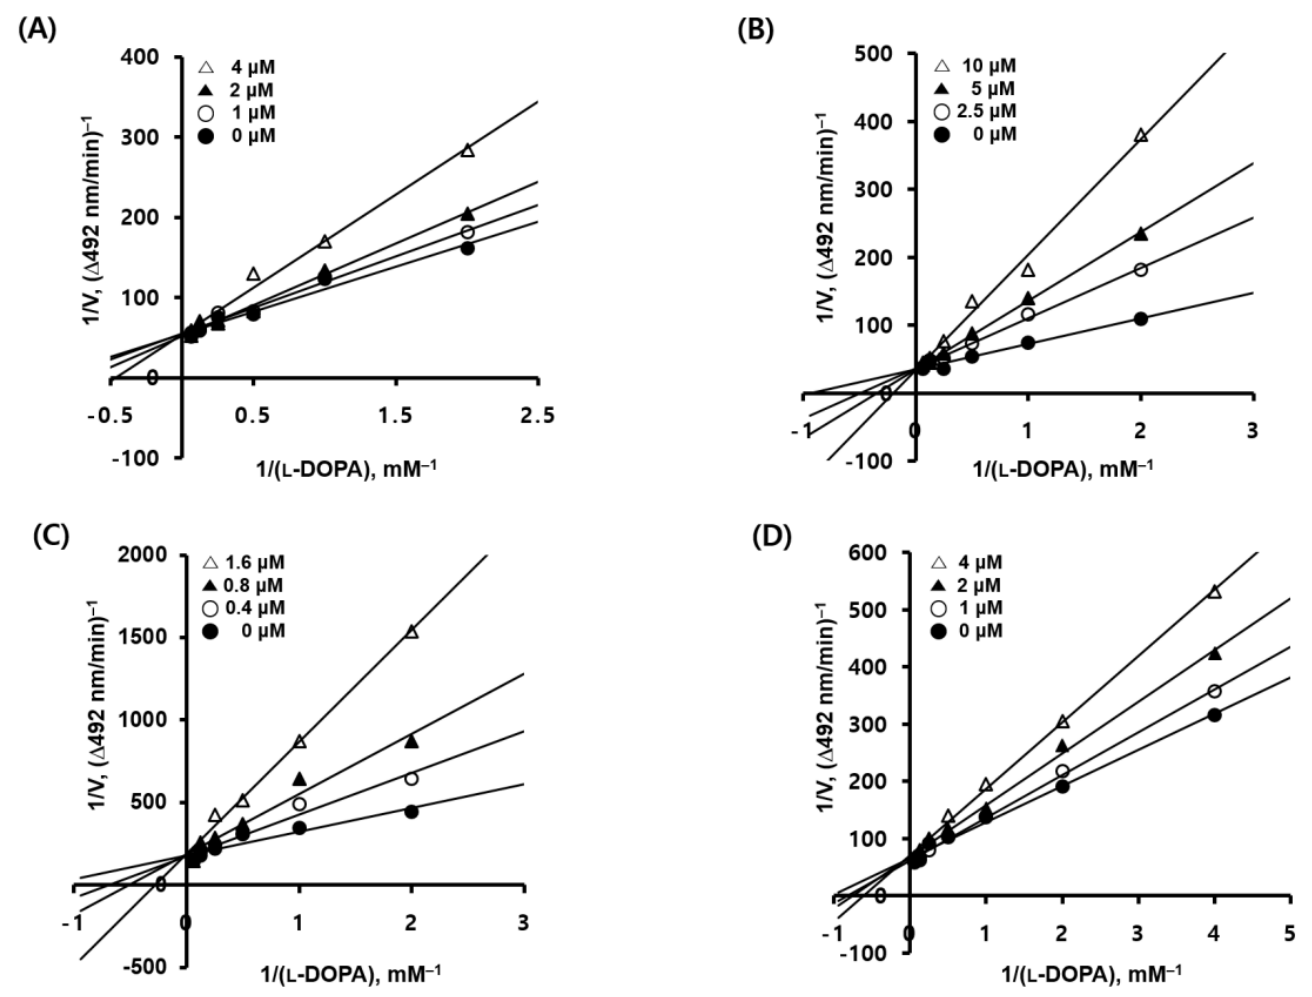
Figure 4. Determination of the modes of action of ( Z )-BPTT analogs. Lineweaver – Burk plots for the inhibition of mushroom tyrosinase by ( Z )-BPTT analogs 1 – 3 ( A – C ) and 6 ( D ). Modes of action were determined by analyzing Lineweaver – Burk plots. Data are mean 1/V values; defined as the inverse of increased dopachrome absorbance per min at a wavelength of 492 nm as determined by three independent experiments using six different concentrations of L -DOPA as substrate. The concentrations of the ( Z )-BPTT analogs used were 0 µM (filled circles), 1 µM (unfilled circles), 2 µM (filled triangles), and 4 µM (unfilled triangles) for analogs 1 and 6 ; 0 µM (filled circles), 2.5 µM (unfilled circles), 5 µM (filled triangles), and 10 µM (unfilled triangles) for analog 2 ; and 0 µM (filled circles), 0.4 µM (unfilled circles), 0.8 µM (filled triangles), and 1.6 µM (unfilled triangles) for analog 3 . The modified Michaelis – Menten equation was used: 1/V max = (1/K M )(1 + [S]/K i ), where V max , K M , [S], and K i represent maximum reaction rate, the Michaelis – Menten constant, L-DOPA concentration, and the inhibition constant, respectively. All experiments were performed independently 3 times.